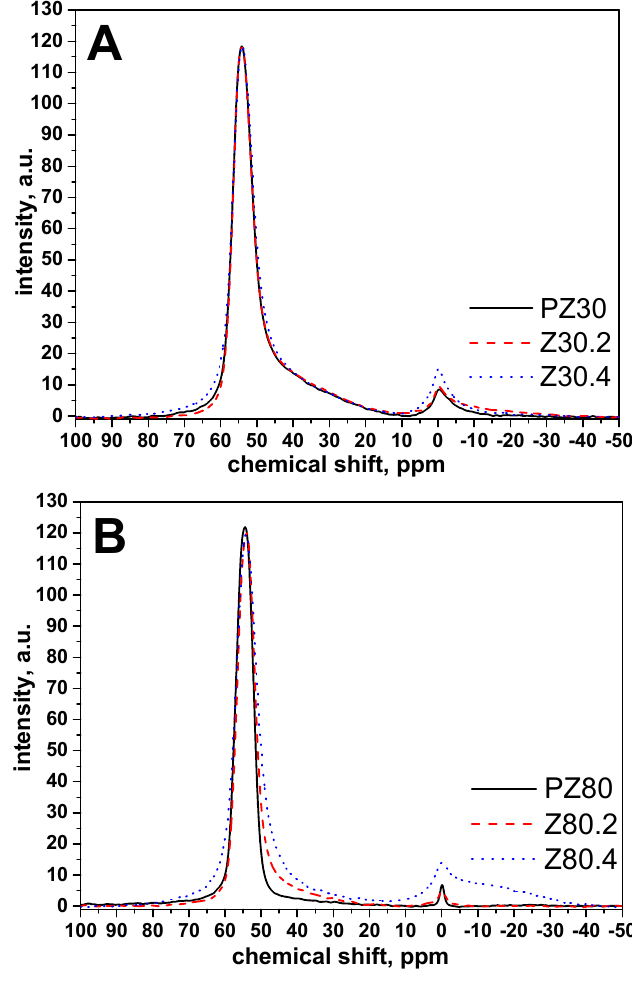
Figure 6. 27 Al MAS NMR spectra of presented zeolites with SiO 2 /Al 2 O 3 ratios 30 (Z30) ( A ) and 80 (Z80) ( B ) before (PZ30, PZ80) and after the desilication treatment (Z30.2, Z30.4, Z80.2, Z80.4). Table 2. Normalised areas and ratios of peaks at 54 and 0 ppm corresponding to framework and extra-framework aluminium. SAMPLE Ratio of Peaks at 54 to 0